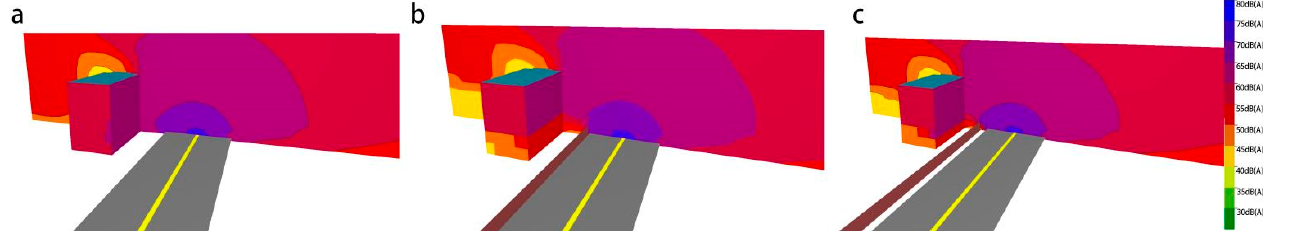
Figure 9. Cross-section simulation of street-facing building noise: ( a ) without acoustic barrier; ( b ) with an acoustic barrier; ( c ) with an acoustic barrier at 2 m.